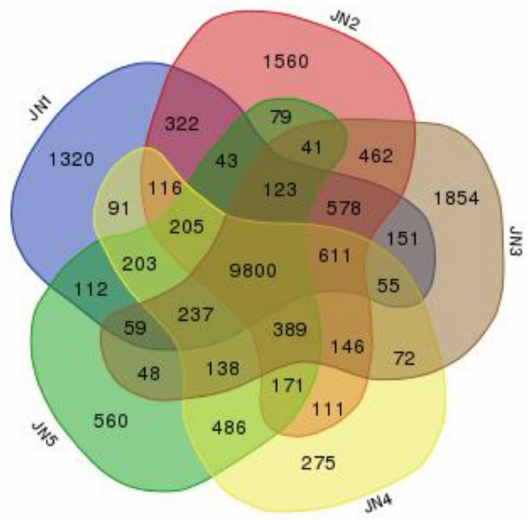
Figure 2. Venn diagram of gene number in the five developmental